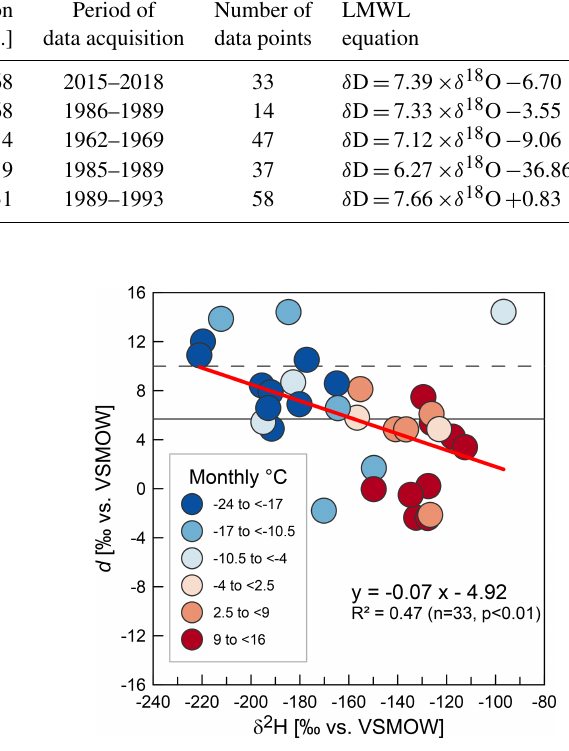
Figure 4. Relationship between hydrogen isotope ratios ( δ 2 H) and deuterium excess d (monthly means). The solid horizontal line in- dicates mean d from Inuvik (this study), whereas the dashed line indicates global average d . Bubble colour indicates air temperature ranges (monthly mean) at the time of sampling. Red line represents the linear